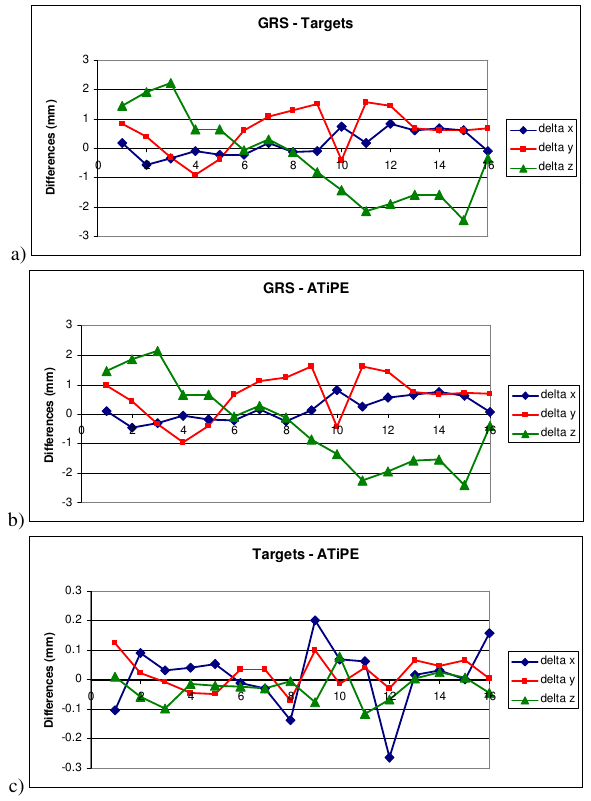
Figure 7. Graphical behaviour of the differences of the ChkP coordinates in the solution obtained using coded targets (a) and natural features extracted with ATiPE (b). The differences between the target and targetless approach are shown in